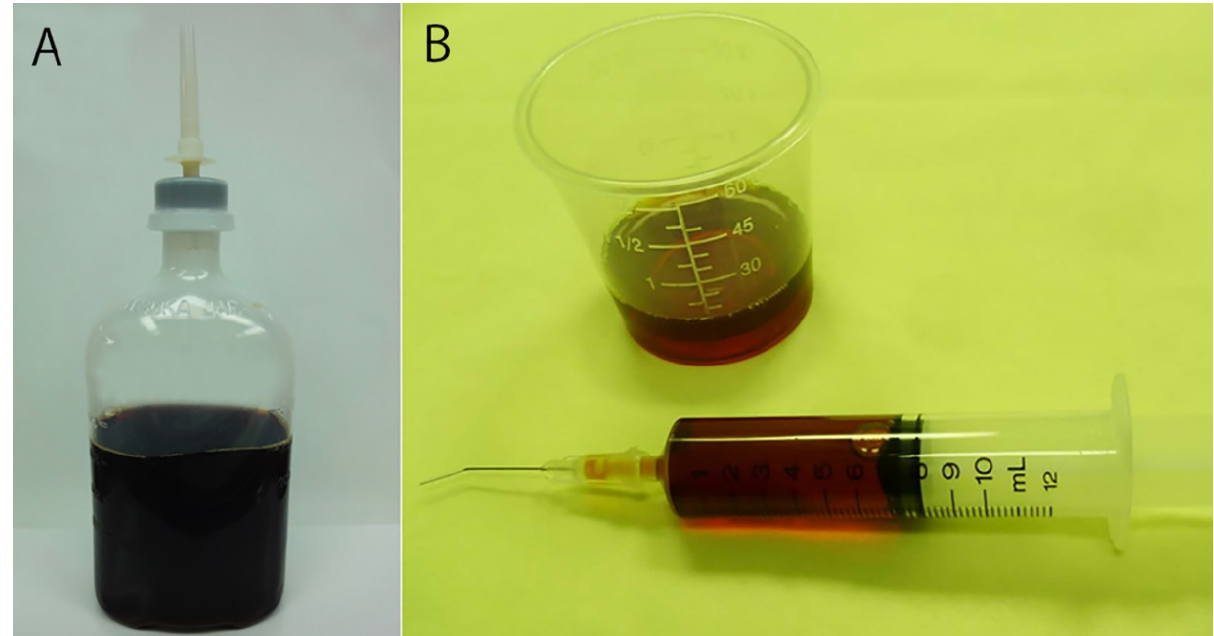
Figure 8. Preparation and use of 0.25% povidone-iodine. ( A ) Inject an appropriate volume of 5% or 10% povidone-iodine into a 250-mL saline bottle to prepare a 0.25% solution, and attach a cleaning needle to the cap. This can also be used to clean the ocular surface before surgery. ( B ) Dispense the solution from the bottle into a cup placed on the operating table, put a syringe in the cup and use during cataract surgery. (Modified from [69]).